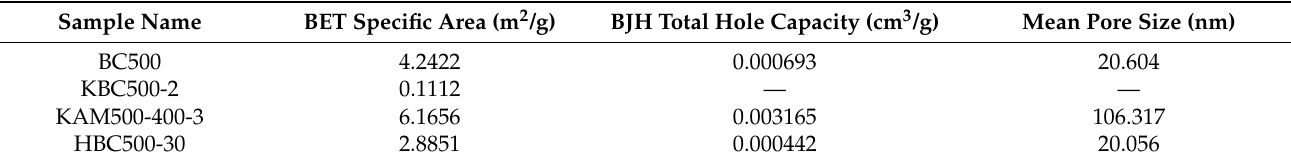
Table 4. The porous structural parameters of the bamboo charcoal and the modified bamboo